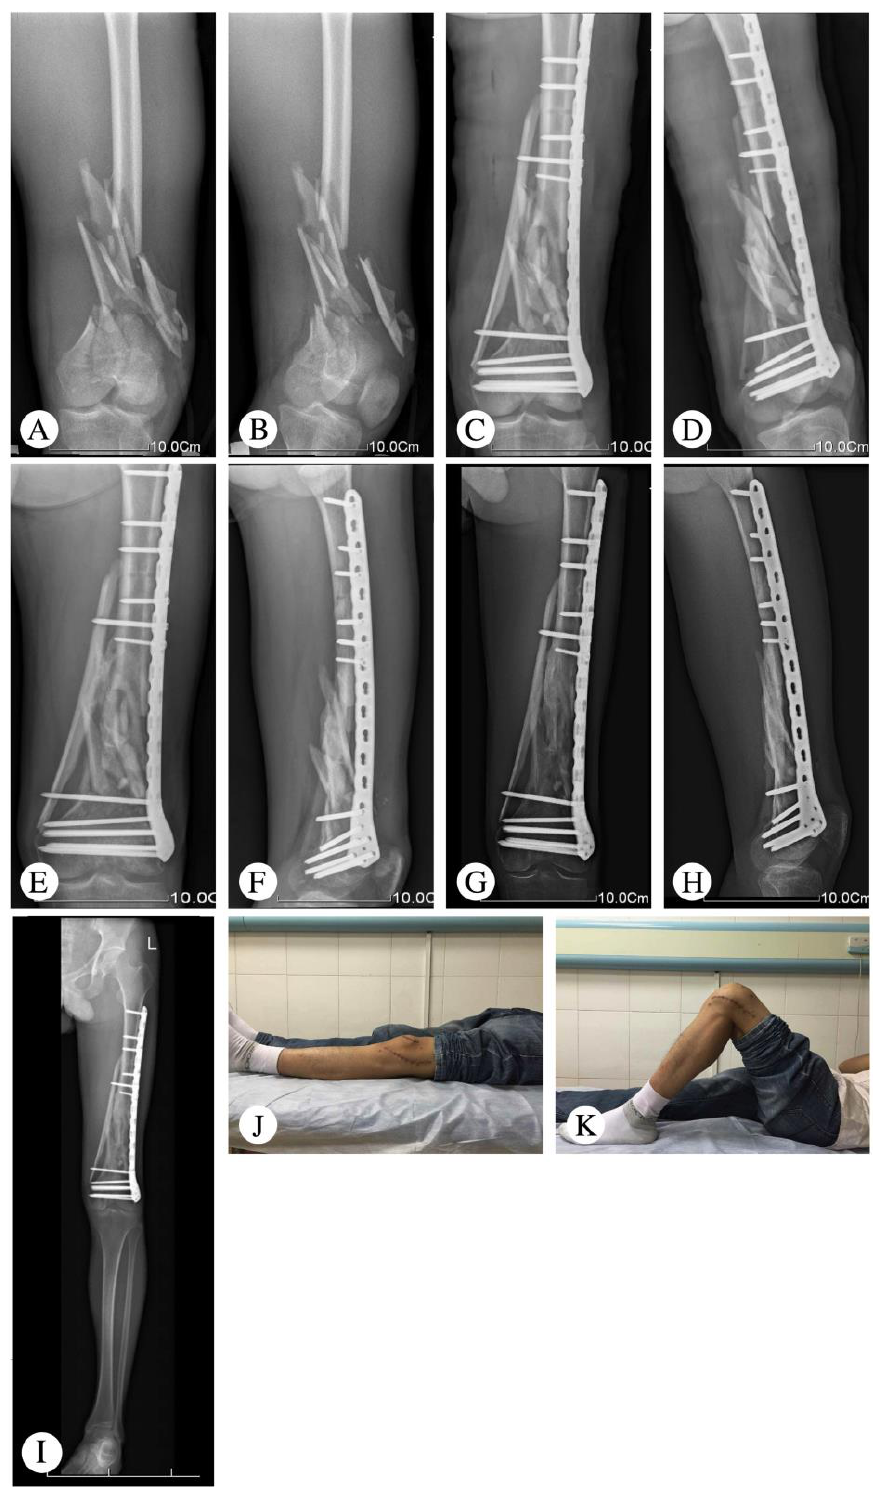
Figure 2. Representative images of Patient 5 (29-year-old male who suffered a heavy object crush to his left thigh). ( A , B ) X-ray at admission. ( C , D ) X-ray 5 days after the operation. ( E , F ) Follow-up X-ray at 3 months. ( G , H ) Follow-up X-ray at 30 months. ( I ) Full-length radiography showing the lower limb at a 33-month follow-up visit. Limb alignment and length was good. ( J , K ) Range of knee joint motion at a 33-month follow-up visit. The patient achieved full knee extension. However, the range of knee flexion was only 90°.